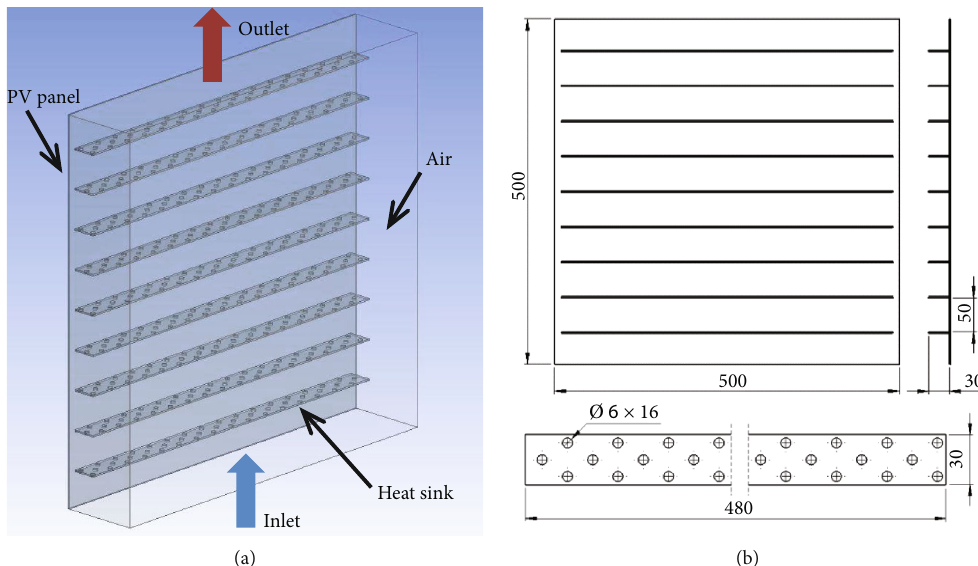
Figure 1: The (a) proposed geometry and (b) dimensions of a PV panel with aluminum heat